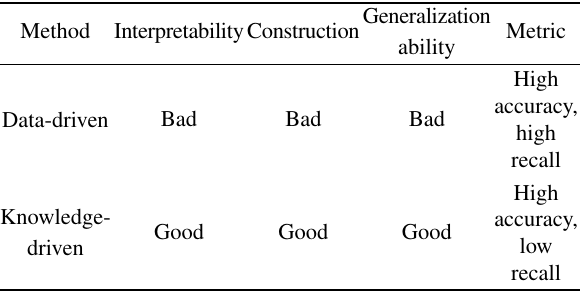
Table 1 Comparison of the two